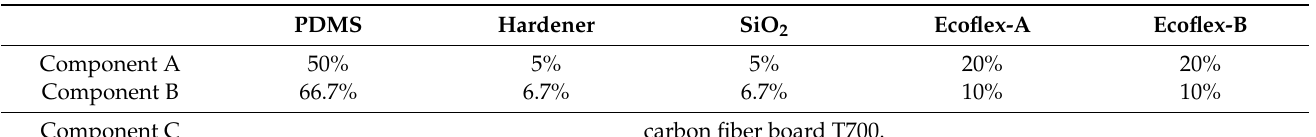
Table 2. Flexible gripper material